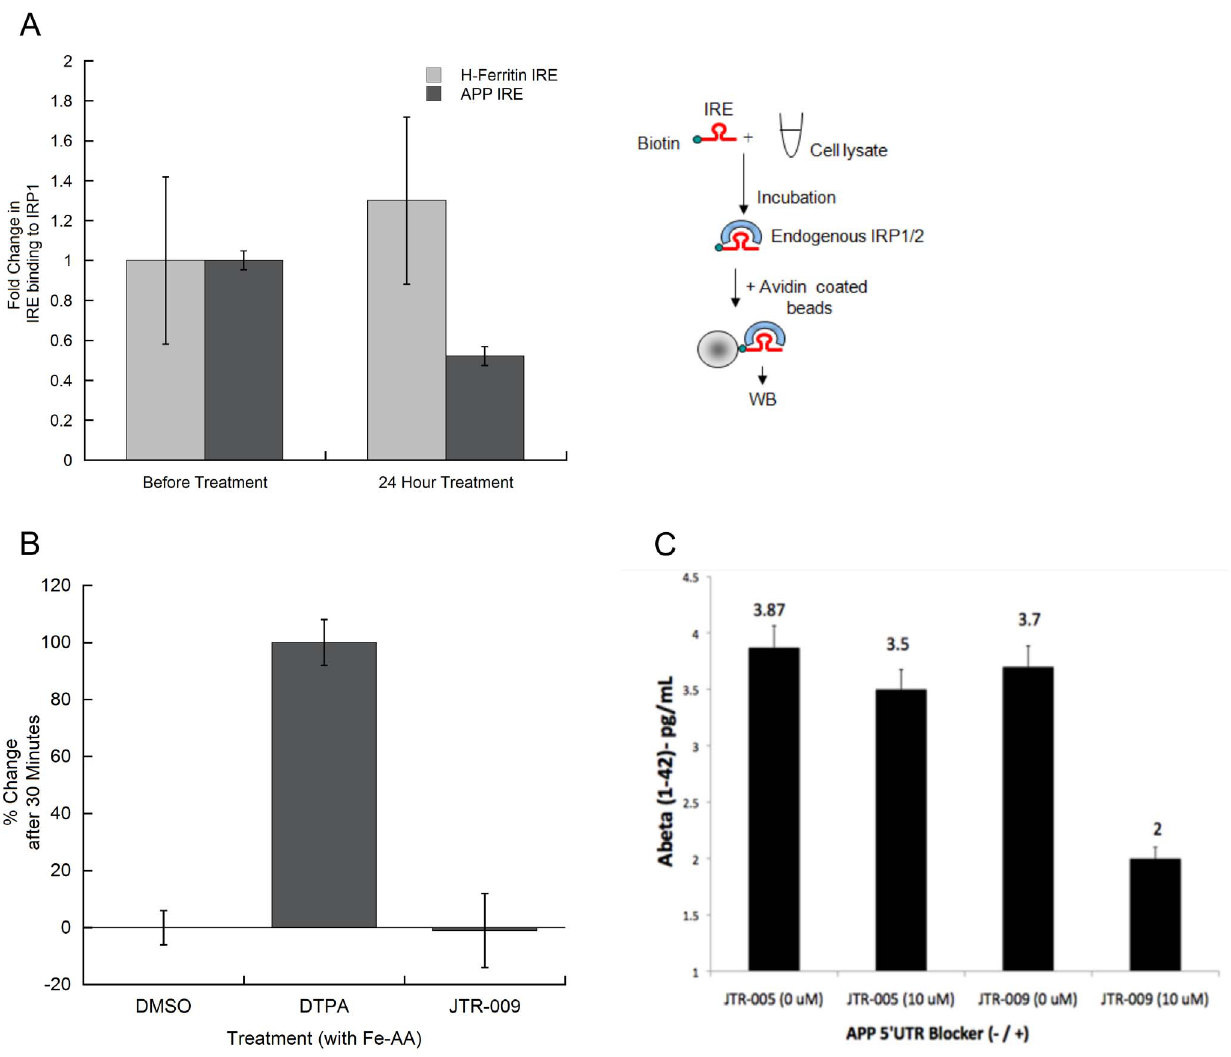
Figure 6. RNA binding assay to measure the capacity of JTR-009 to replace IRP1 binding to biotinylated probes encoding core APP IRE sequences compared to IRP1 binding to the H-ferritin IRE sequences (N=4). Panel A : Top Panel: Cartoon representation of the protocol employed to detect RNA binding between IRE probes and IRP1 in SH-SY5Y cell lysates. Bottom Panel: Effect of JTR-009 treatment of SH-SY5Y cells (24 h, 10 m M) to alter ferritin-H IRE binding to IRP1 compared to that of the APP IRE. Panel B : The calcein assay for iron levels in SH-SY5Y cells in response to treatment with JTR-009. Cells were treated with either DMSO (negative control), extracellular iron chelator (DPTA), or JTR-009 at 10 m M for 48 hours. Panel C : The anti-amyloid-A b -42 efficacy of the APP 5 9 UTR inhibitors JTR-005 and JTR-009, as measured in conditioned medium from SH-SY5Y neuronal cells (Chemiluminescent BetaMark x-42 ELISA assay from Covance, inc). Data shows the mean values for the reduction of levels of A b -42 6 SEM (N=3) after 72 h treatment of the cells with JTR-009 compared to JTR-005 at 10 m M (p , 0.01), analyzed by ANOVA.